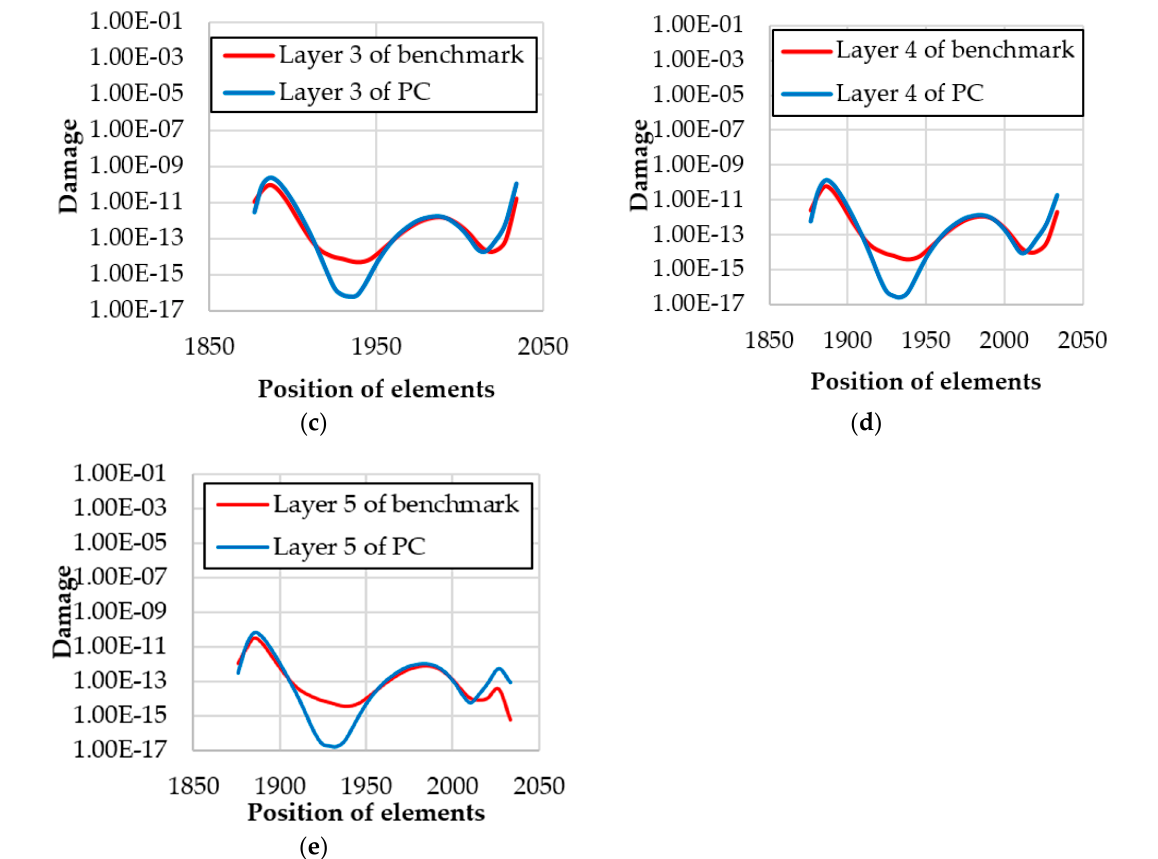
Figure 20. Comparison of the benchmark and PC models on each layer: (a) Comparison of the results of layer 1 in each model; (b) Comparison of the results of layer 2 in each model; (c) Comparison of the results of layer 3 in each model; (d) Comparison of the results of layer 4 in each model; (e) Comparison of the results of layer 5 in each model.